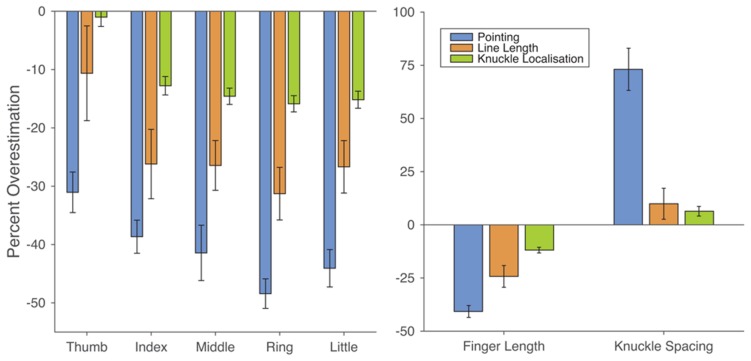
Results from the three tasks of Experiment 1.
(Left) Overestimation of finger length as a function of the five fingers across the three tasks. Clear underestimation was found for all three tasks, which increased across the hand from thumb to little finger. The magnitude of underestimation, however, differed across tasks, being largest for the pointing task, intermediate for the line length task, and smallest for the knuckle localisation task. (Right) Overestimation of finger length (i.e., the data from the left panel collapsed across the five fingers) and of hand width (i.e., the distance between the knuckles of the index and little fingers) across the three tasks. While modest overestimation of hand width was found for the line length and knuckle localisation tasks, it was dramatically smaller than in the pointing task.